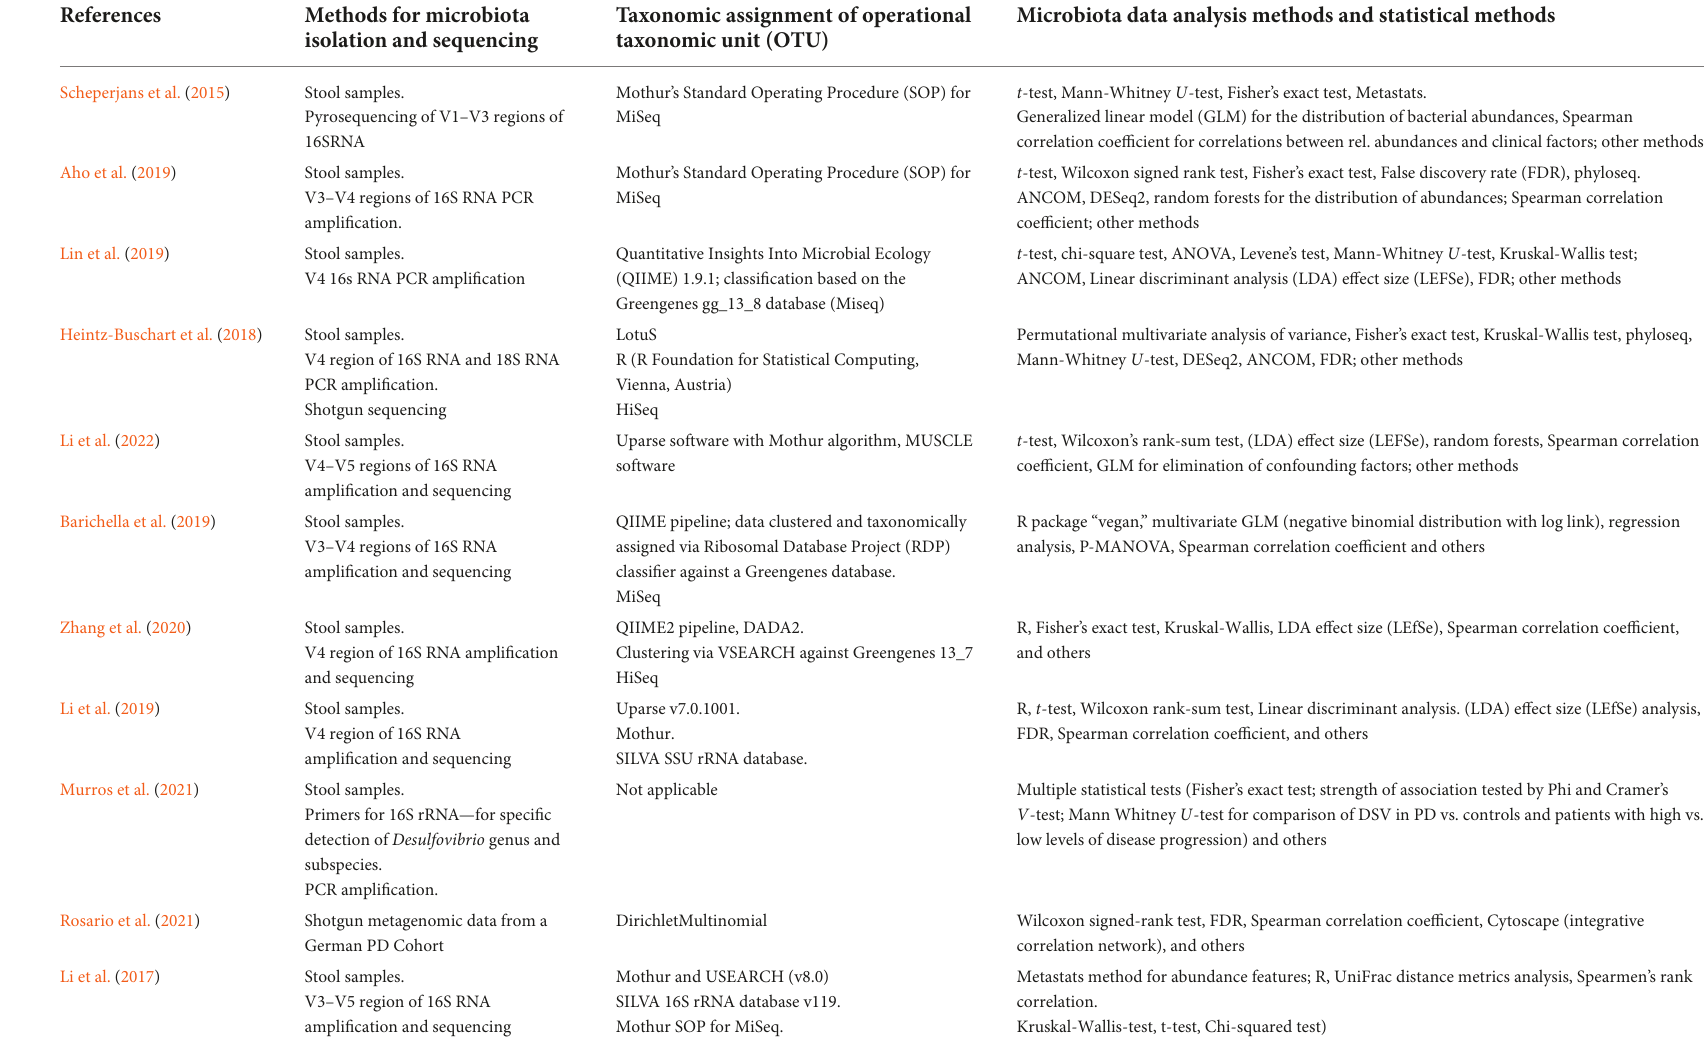
TABLE 2 Methods for microbiota isolation, sequencing, taxonomic assignment, data, and statistical